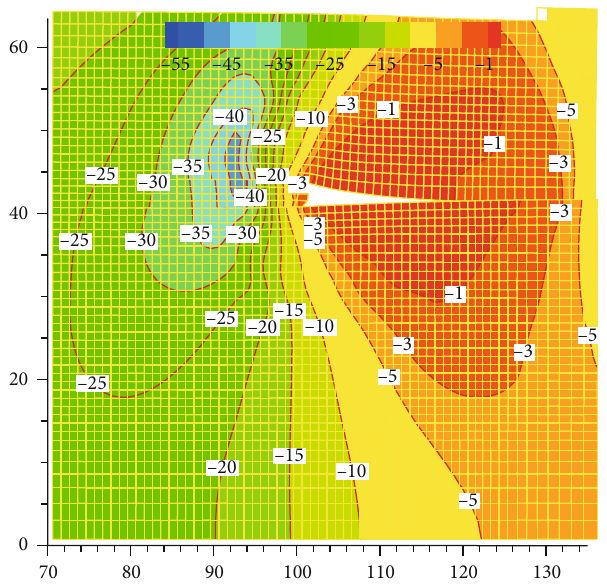
Figure 8: Distribution law of fl oor stress fi eld after 15 m, and vertical distance is 20 m, but the relative direction is di ff erent.